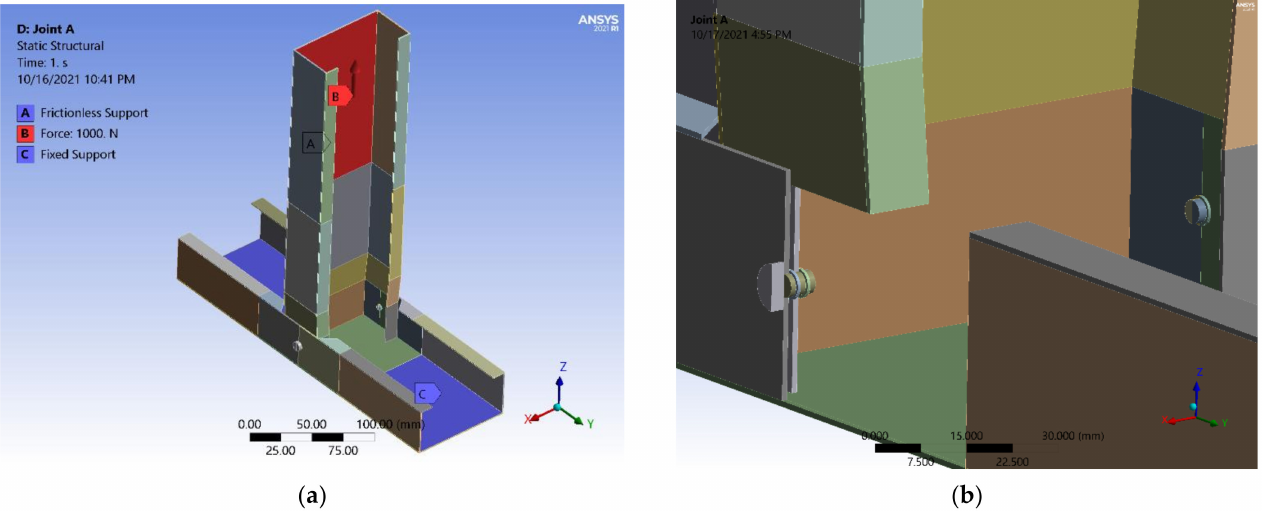
Figure 22. Joint A geometry: ( a ) Static schema; ( b ) detail of screws with hidden body